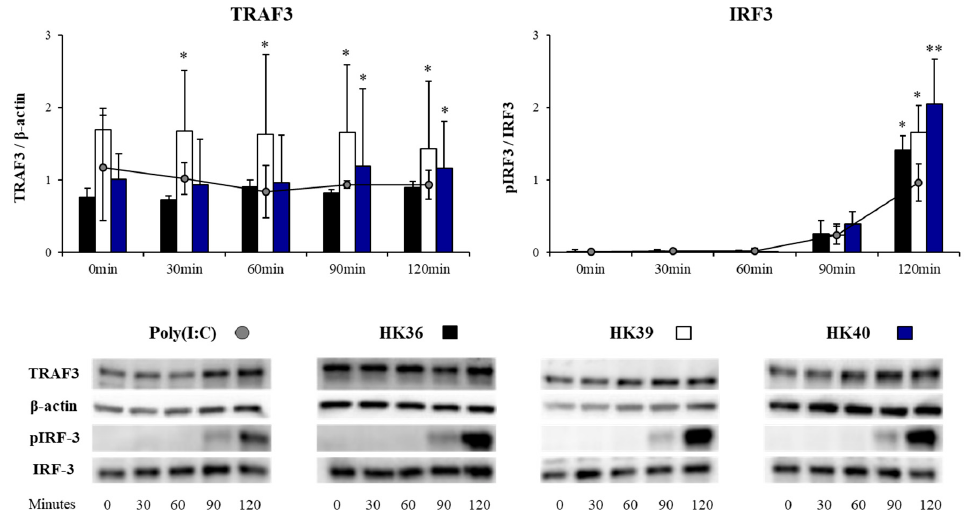
Figure 8. Effect of non-viable Lactobacillus gasseri strains on signaling pathway in porcine alveolar macrophages after the activation of Toll-like receptor 3 (TLR3). Alveolar macrophages were stimu- lated with non-viable L. gasseri TMT36 (HK36), TMT39 (HK39), or TMT40 (HK40) and then challenged with the TLR3 agonist poly(I:C). The proteins from lysed cells were extracted at the indicated time points and separated by SDS-PAGE. Western-blot was performed to quantify TRAF3/ β -actin and p-IRF3/IRF3 ratios. Intensities of proteins bands were calculated from peak area of densitogram by using image Lab software. Non-lactobacilli treated alveolar macrophages challenged with poly(I:C) were used as controls. The results represent data from three independent experiments. Significant differences were observed when compared to polyI(:C)-challenged control porcine alve- olar macrophages. * ( p < 0.05), ** ( p < 0.01). As expected, the challenge of porcine alveolar macrophages with poly(I:C) signifi- cantly increased the levels of TRAF3 from min 30 to 120, as well as the p-IRF3/IRF3 ratio, indicating the activation of the TLR3 pathway (Figure 8). The levels of TRAF3 were sig- nificantly increased in alveolar macrophages treated with HK39 from min 30 to 120, while this factor was increased from min 90 to 120 in macrophages treated with HK40. Of note, TRAF3 was not different from control cells in alveolar macrophages stimulated with HK36. The three HK36, HK39 and HK40 treatments enhanced the p-IRF3/IRF3 ratio when compared to control cells at min 120 (Figure 8). Our previous studies demonstrated that immunobiotics modulate the TLR3 signal- ing through the induction of changes in the expression of negative regulators of the TLR signaling pathway [24,25]. Thus, we next evaluated the expressions of Tollip , A20 , MKP-1 , Bcl-3 , SIGIRR and IRAK-M in alveolar macrophages stimulated with HK36, HK39 or HK40 and then challenged with poy(I:C) (Figure 9).